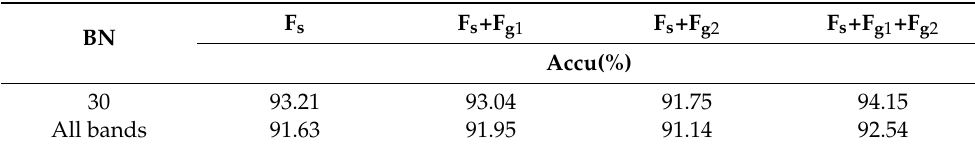
Table 4. Combination classification results (%) of spectral features and spatial features of the Bohai Bay